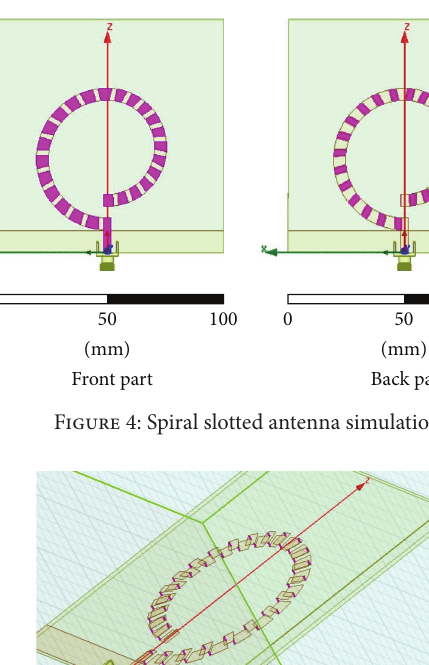
Figure 3: Half-turn spiral slotted microstrip antenna geometry.